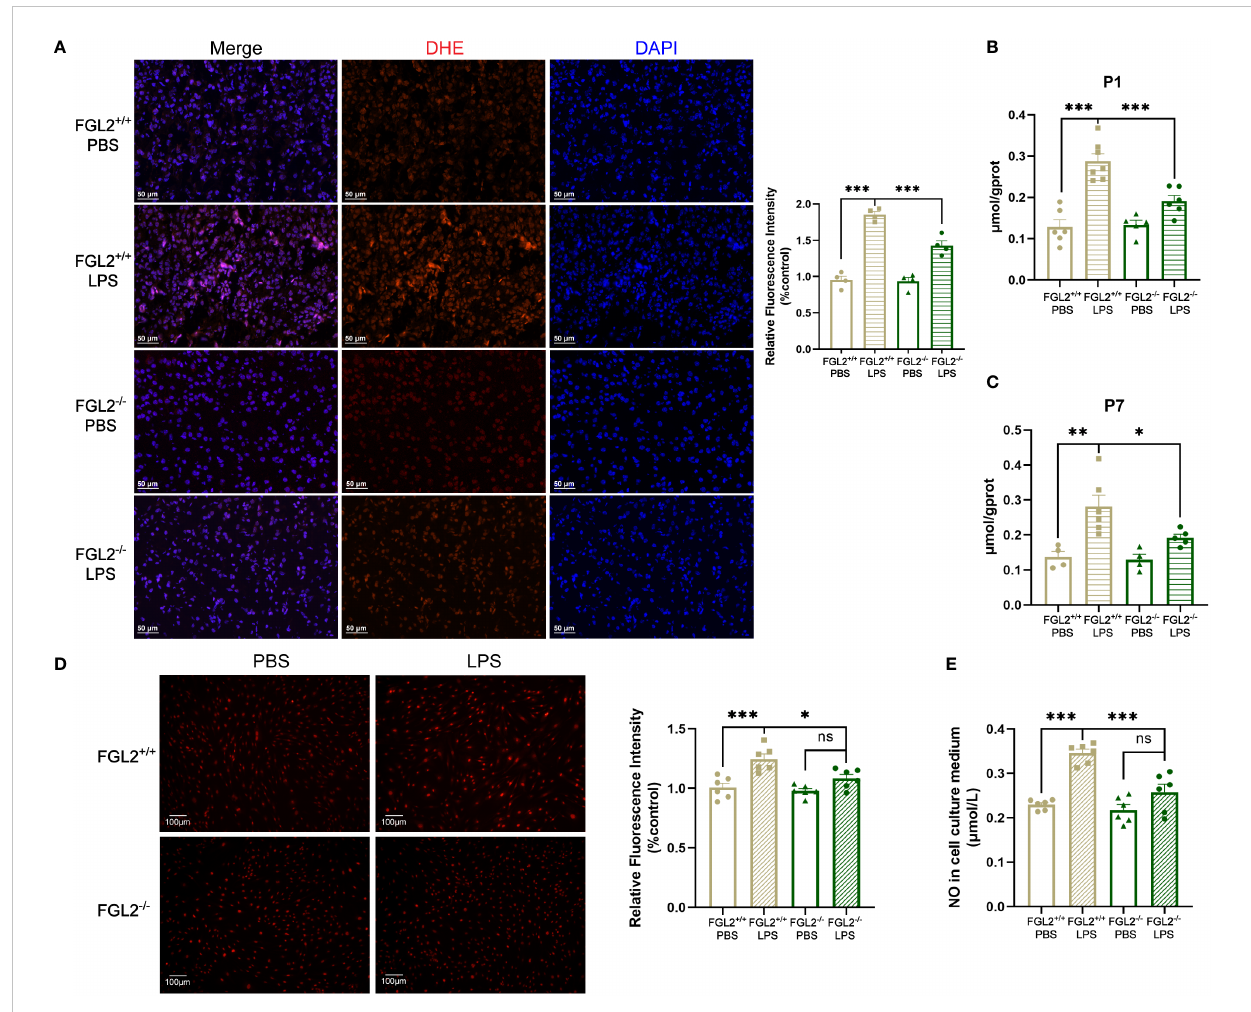
FIGURE 3 FGL2 de fi ciency decreased the maternal in fl ammation-induced generation of ROS and NO. (A) The level of ROS by DHE staining in cortex at P7 ( n = 4). Representative images were shown and quantitative results were normalized to controls. Scale bar=50 m m. (B) The NO contents in brain at P1 ( n = 6:7:5:6). (C) The NO contents in cortex at P7 ( n = 4:6:4:5). (D) The level of ROS by DHE staining in BMECs ( n = 6). FGL2 +/+ and FGL2 -/- BMECs were treated with LPS (5 m g/ml) or PBS for 24 h. Representative images were shown, and quantitative results were normalized to controls. Scale bar=100 µm. (E) The concentration of NO in culture mediums of BMECs ( n = 6). The data was expressed as mean ± SEM and was the representative of at least three independent experiments. Statistical differences were assessed by one-way ANOVA with Tukey ’ s post-hoc test for multiple